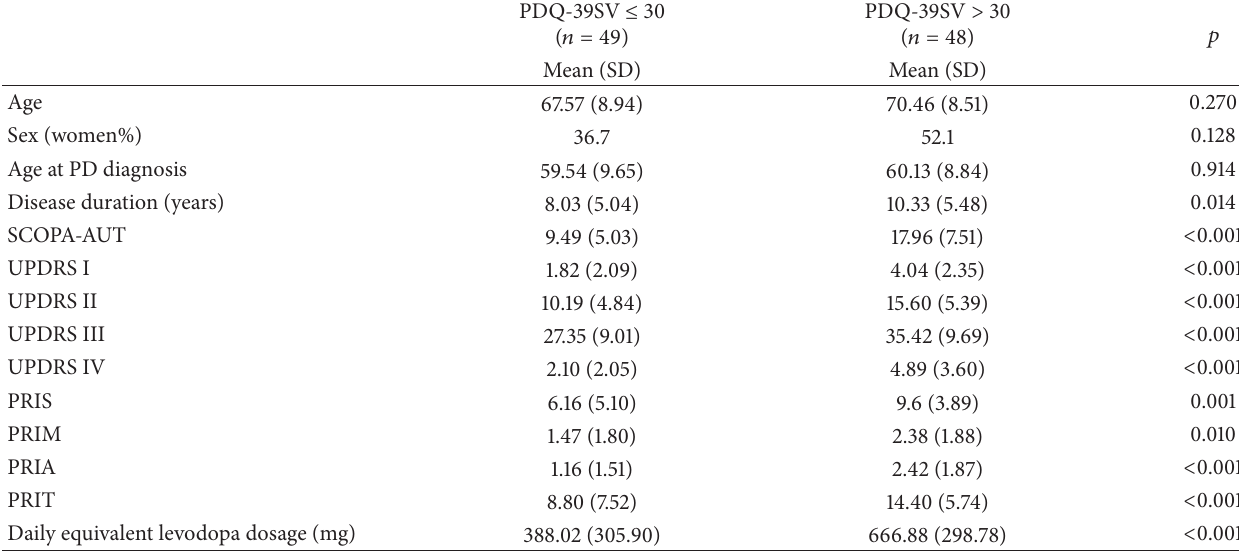
Table 1: Bivariant analysis by quality of life (PDQ-39SV > 30 versus PDQ-39SV ≤ 30) 𝑛 = 97